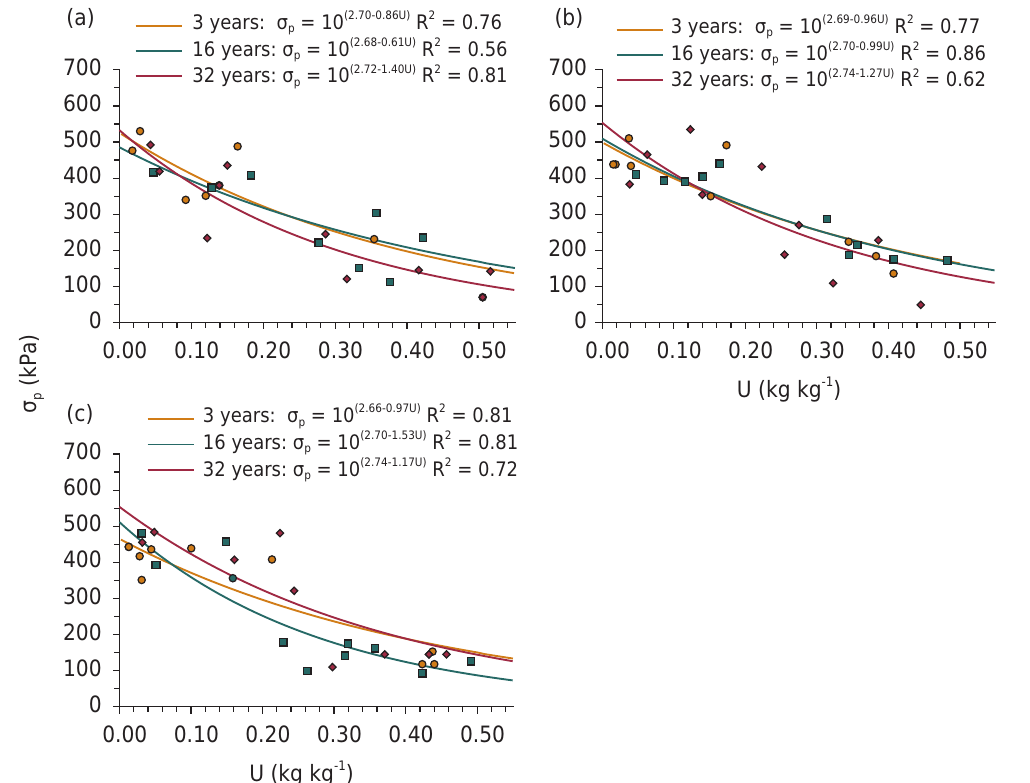
Figure 4. Soil load-bearing capacity models in function of the water content (U) of an Ultisol with coffee cultivation in areas with different deployment times (3, 16, and 32-years areas), under mechanized management systems, in the inter-row center, at different soil layers: 0.10-0.20 m (a), 0.10-0.20 m (b), and 0.20-0.40 m